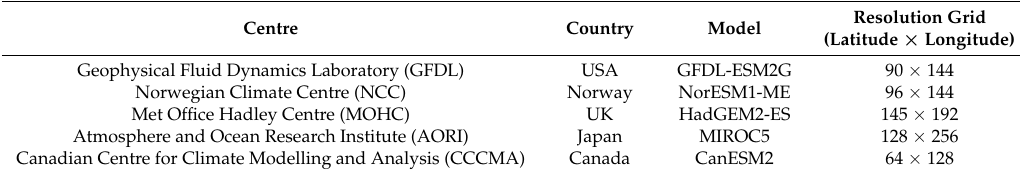
Table 2. Description of five global climate models (GCMs) used in the present study.